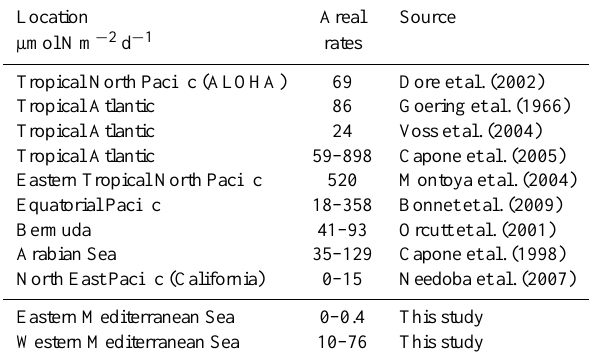
Table 2. Examples of studies showing the range of oceanic N 2 fixa- tion areal rates measured in some contrasting oceanic